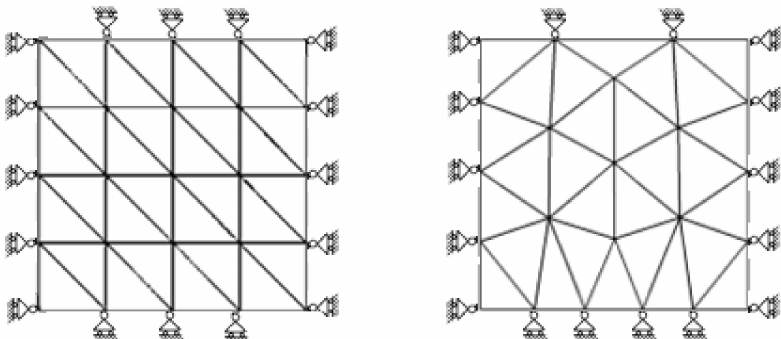
Figure 1. Plate domain: regular/irregular discretization schemes with boundary